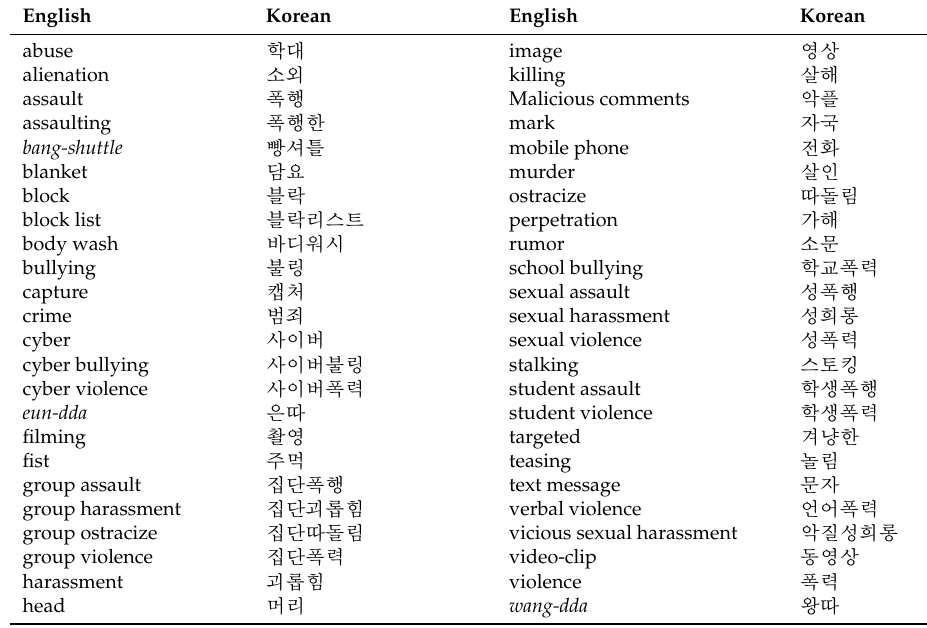
Table A1. English-Korea translation of 48 terms regarding specific forms of school bullying mentioned in the